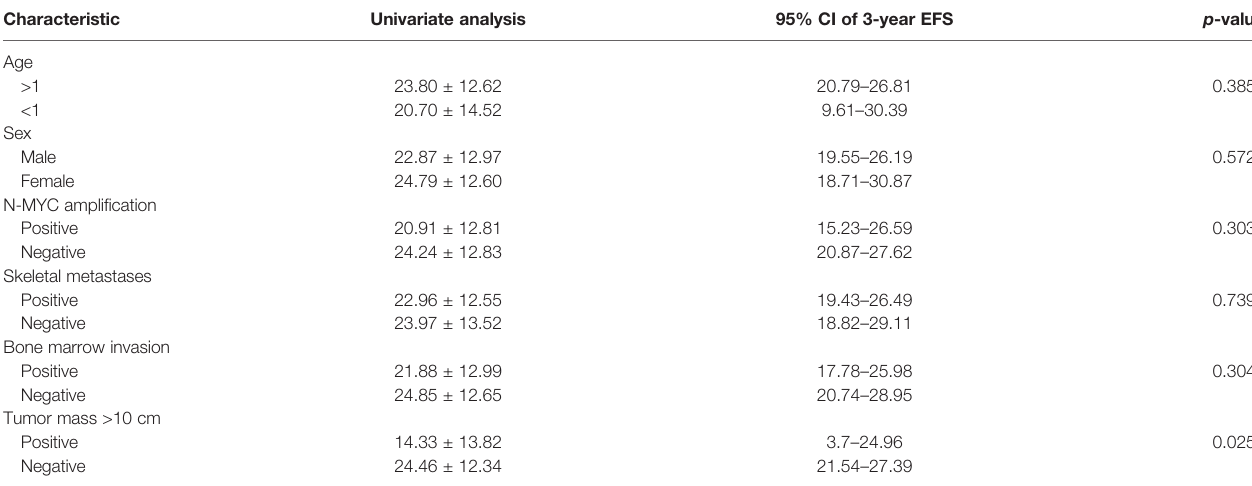
TABLE 6 | Univariate analysis of prognostic factors for 3-year PFS in 80